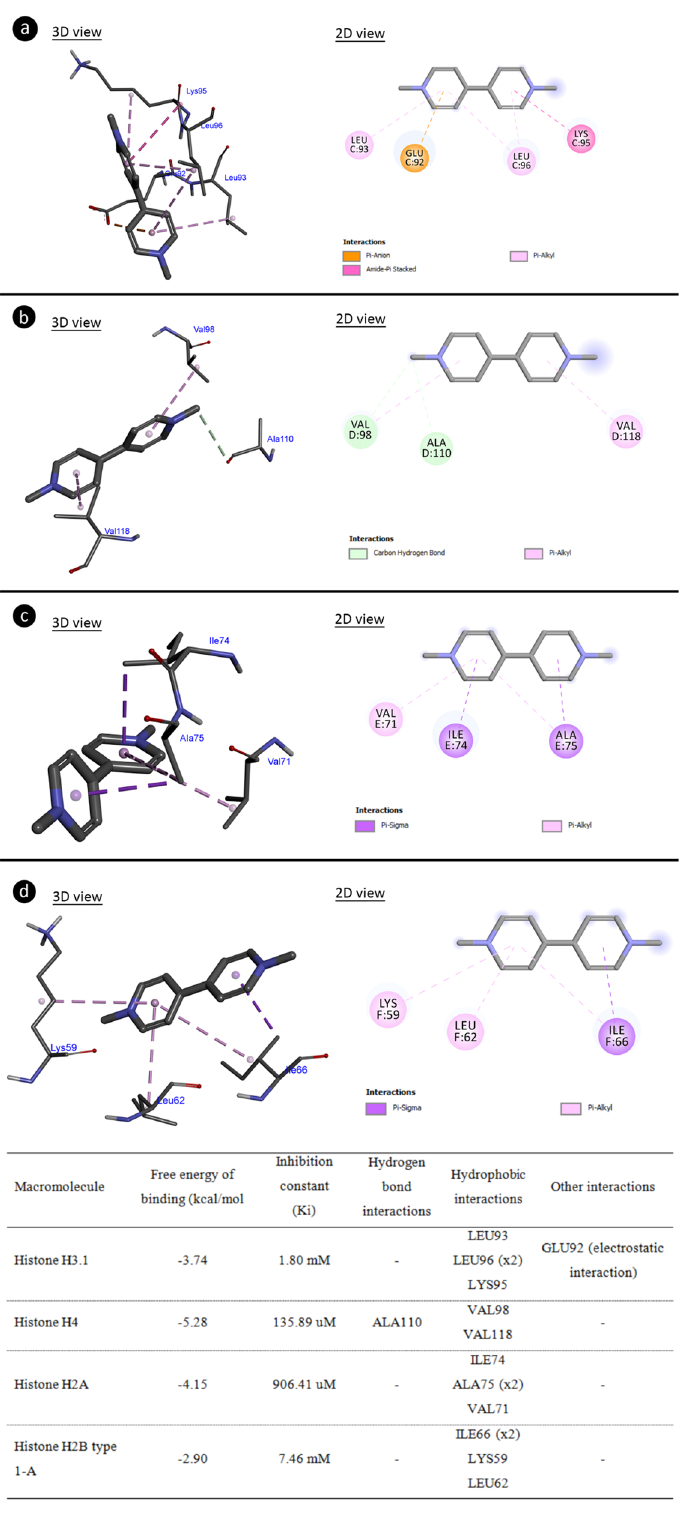
Figure 3. The structural interaction of Paraquat with histone proteins. Histone H3.1-Paraquat complex ( a ), histone H4-Paraquat complex ( b ), histone H2A-Paraquat complex ( c ), histone H2B type 1A-Paraquat complex ( d ) and the binding affinities/interactions of Paraquat with histone